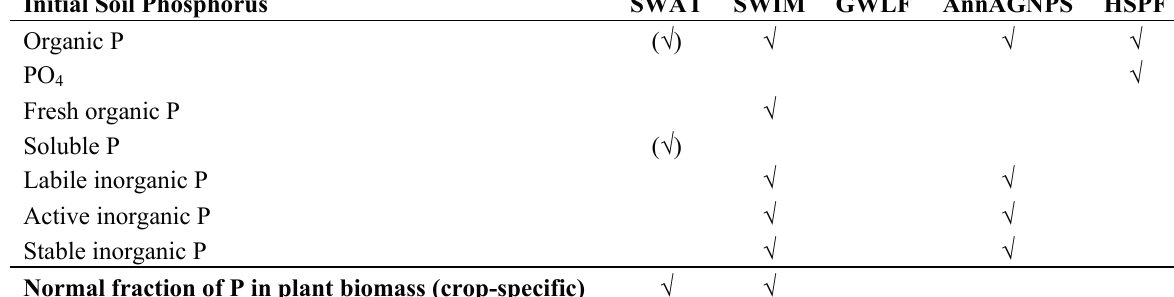
Table 4. Phosphorus input (“( √ )” means this input can be either supplied by measurements, or calculated by the model using